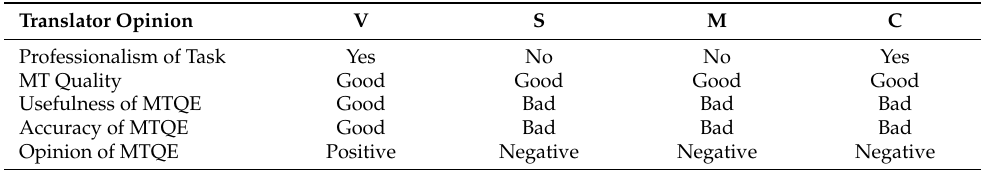
Table 11. Professional Translators and their Opinions after participating in the user